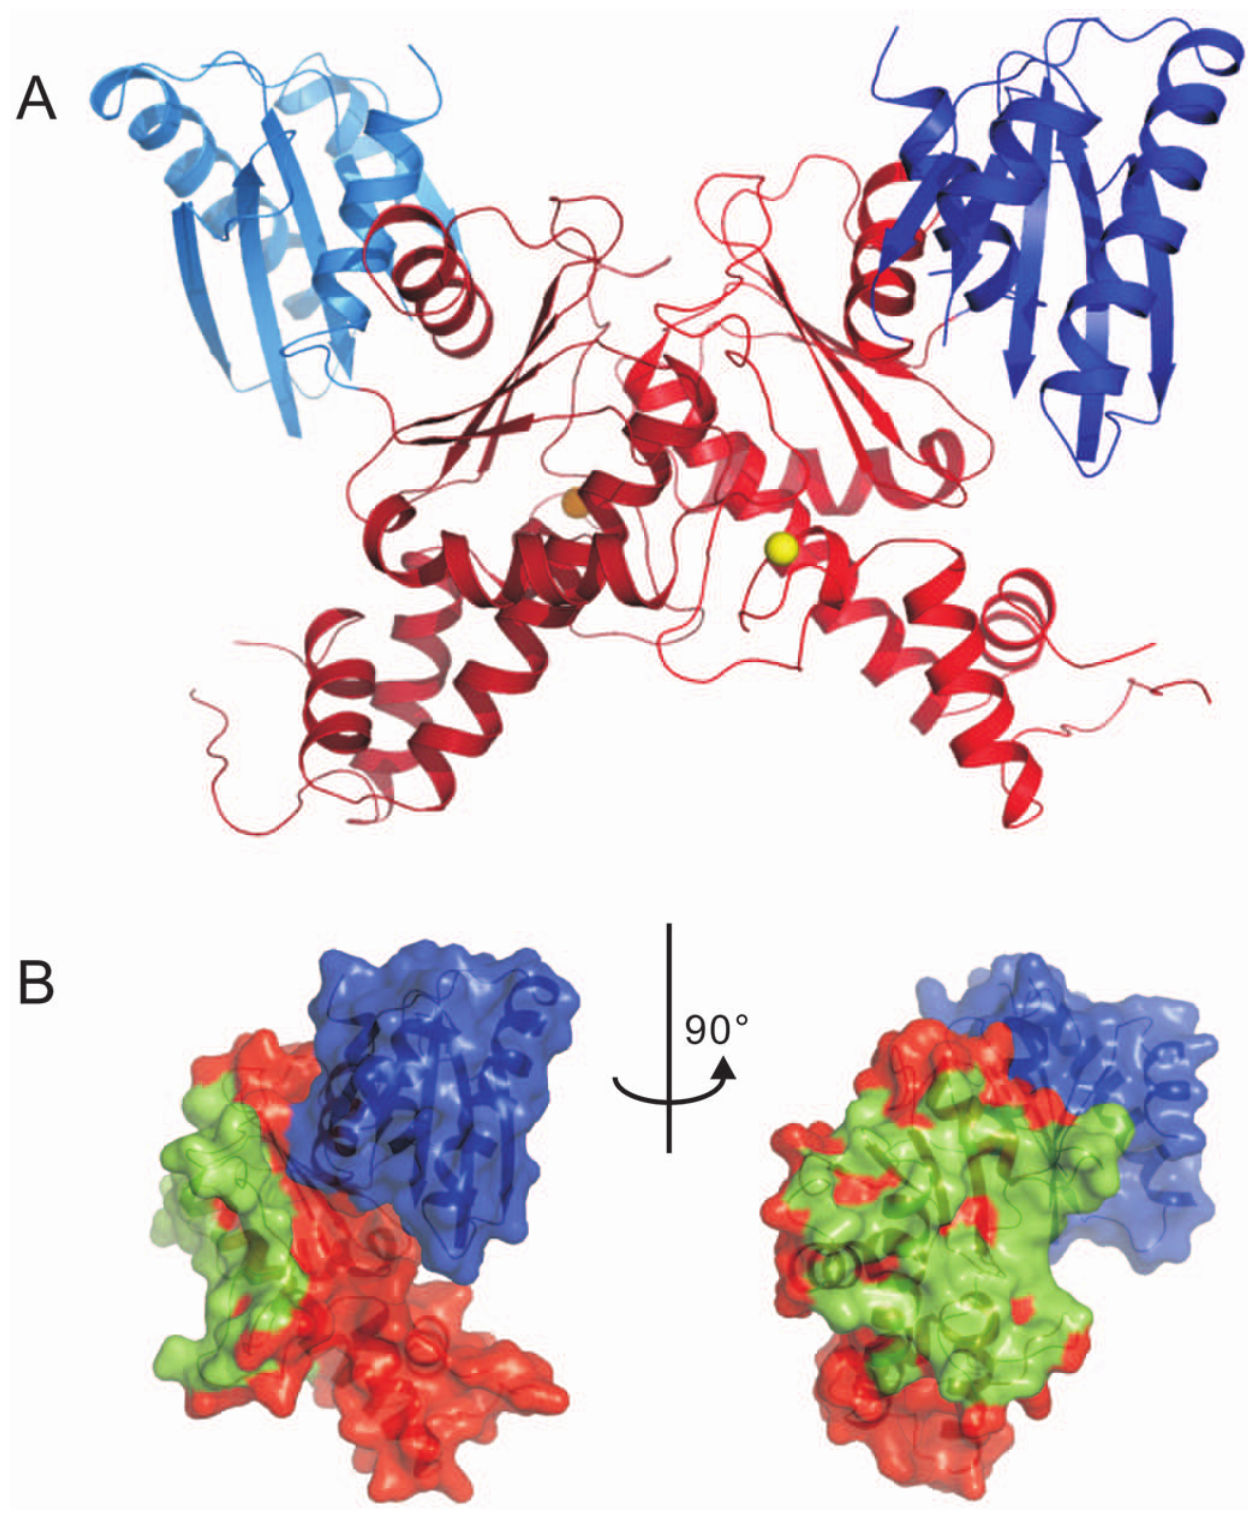
Figure 4. Dimeric GNE kinase domain. Panel A: Ribbon representation of the dimeric structure of the kinase domain. The N-lobes are shown in blue colors, the C-lobes in red. Panel B: Orthogonal views of the protein surface of one of the monomers. Residues within 4 A˚ distance from the other monomer are colored green.